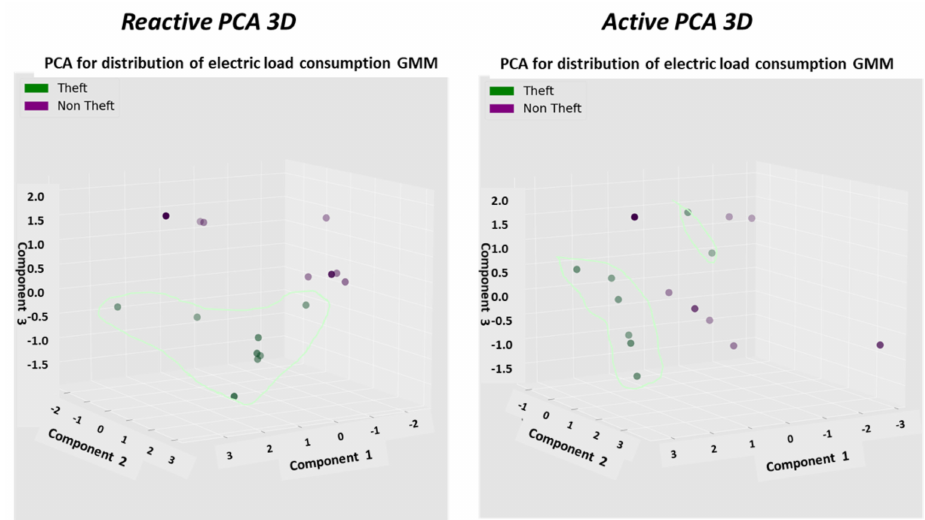
Figure 13. Active ( right ) vs. reactive ( left ) 3D PCA plot of energy distribution as a six-parameter Gaussian mixture model—frauds are scattered green. Non-frauds are dark blue and